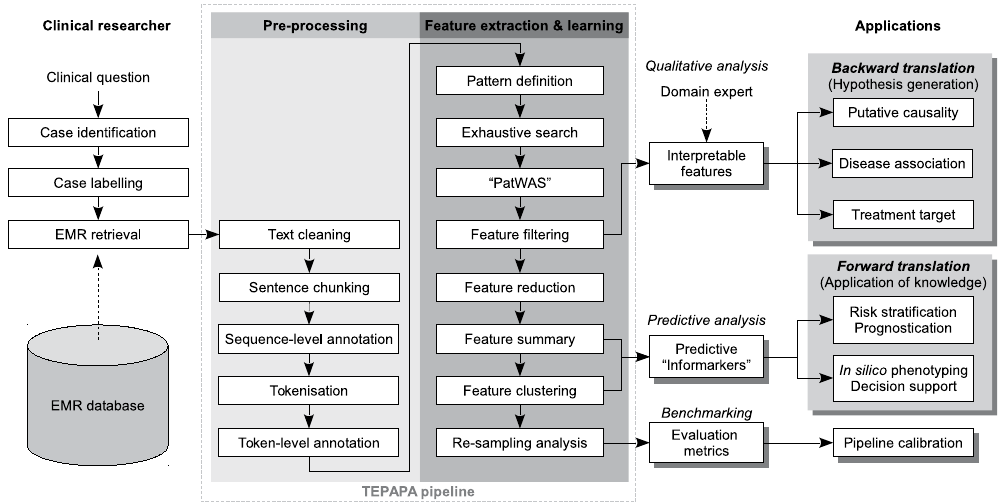
Figure 1. The TEPAPA discovery pipeline. Abbreviations: EMR: electronic medical